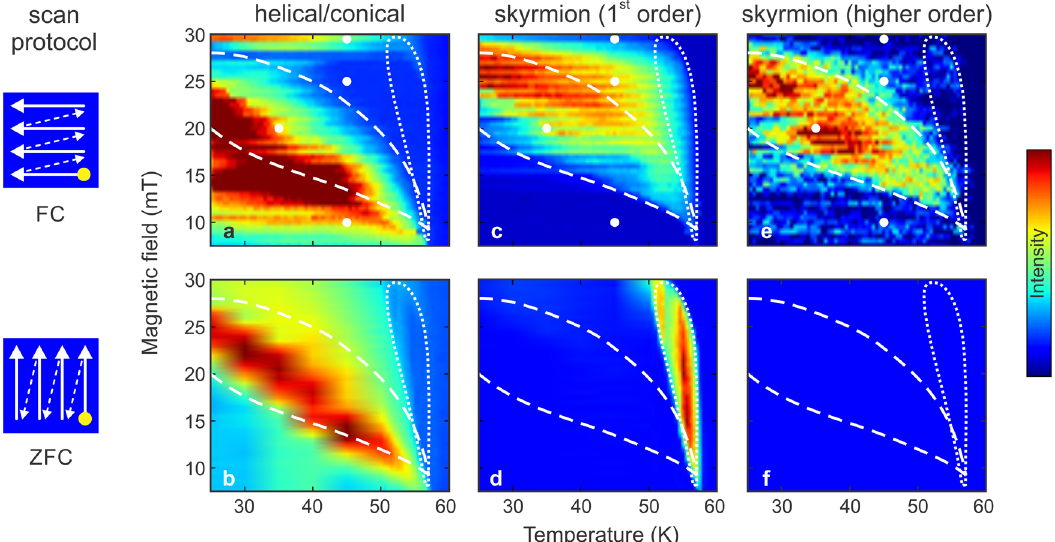
Fig. 3 Magnetic phase diagrams for different fi eld-temperature protocols. The magnetic fi eld-temperature phase diagrams show the scattered peak intensity for the helical/conical phase in a and b . For the skyrmion phase, the maps for the (ordinary) fi rst-order peaks are shown in c and d and those for the higher-order peaks in e and f . Both phase diagrams differ notably. The measurements were carried out using a, c, e a fi eld-cooling and b, d, f zero- fi eld-cooling protocol, as illustrated by white arrows in the insert (starting from the high- temperature, low- fi eld point shown in yellow). The white dotted and dashed lines in the plots provide a guide to the eye for comparing the position of the two skyrmion pockets between the panels. Note that the higher-order skyrmion peaks become much more intense when the helical/conical and skyrmion re fl ections coexist, indicating a transformation of the magnetic structure. The circles show the data extracted from the example images in Fig. 2.